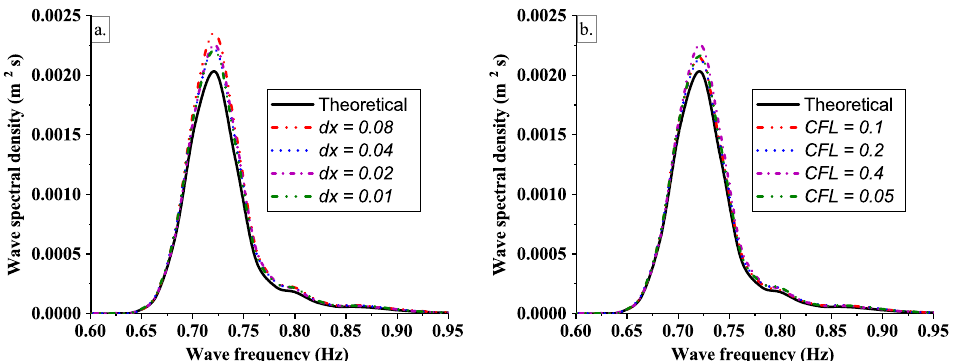
Figure 6. Influence of grid size ( dx ) and CFL number on the reconstruction of irregular waves for the case of T p = 1.4 s and H is = 0.12 m. ( a ) CFL = 0.1 and varying dx , ( b ) dx = 0.02 m and varying CFL numbers.